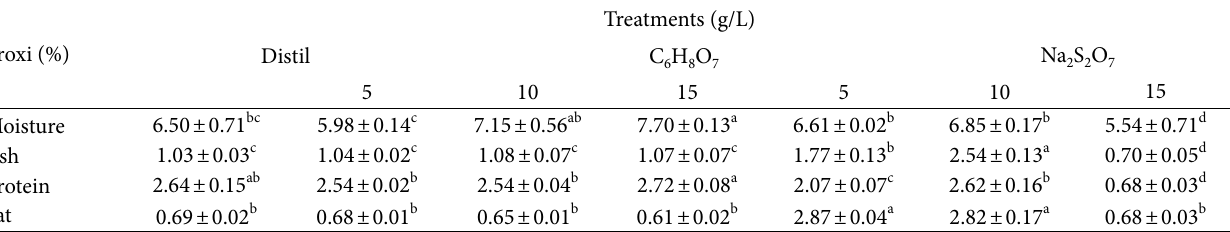
Results are mean ± standard deviation. Values in the same row followed by different letters are significantly different ( 𝑝 < 0.05 ). Distil: distill water, C